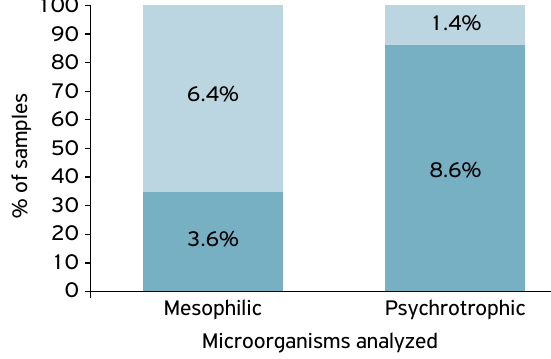
Figure 2. Mean count of mesophilic and psychrotrophic microorganisms found in milk-producing rural farms and in the sample from the milk transport tanker at the entrance of the processing milk